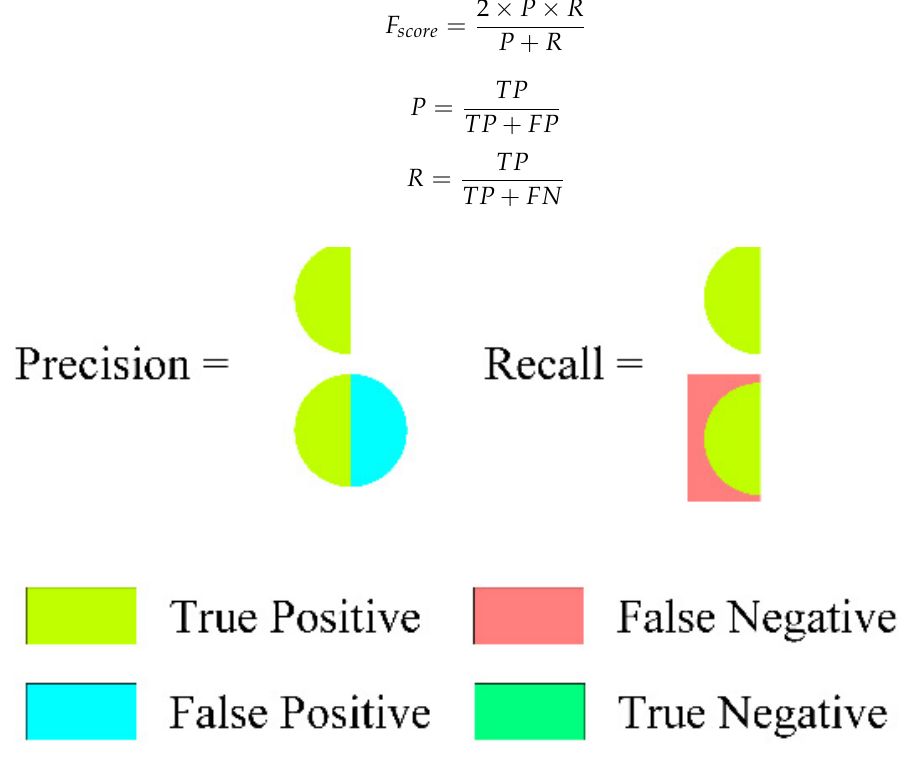
Figure 7. Precision and recall (adapted from [50]).